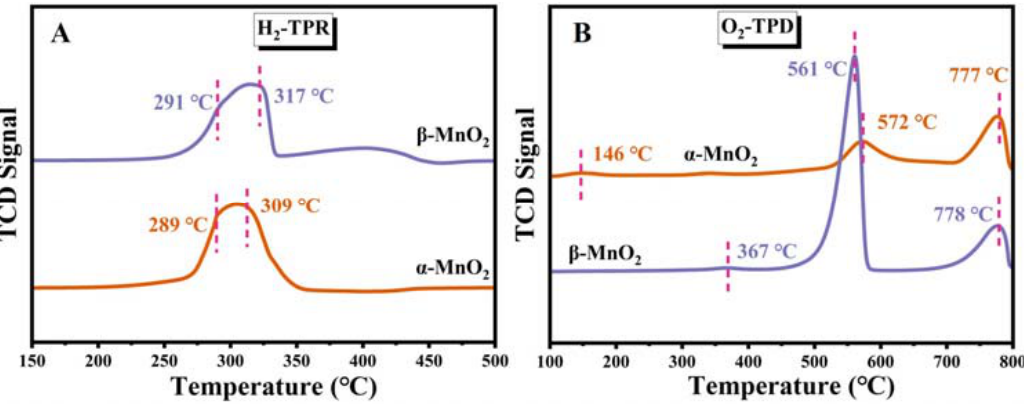
Figure 7. H 2 -TPR ( A ) and O 2 -TPD ( B ) profiles α -MnO 2 and β -MnO 2 . O 2 -TPD was conducted further to explore the oxygen species of the MnO 2 catalysts.